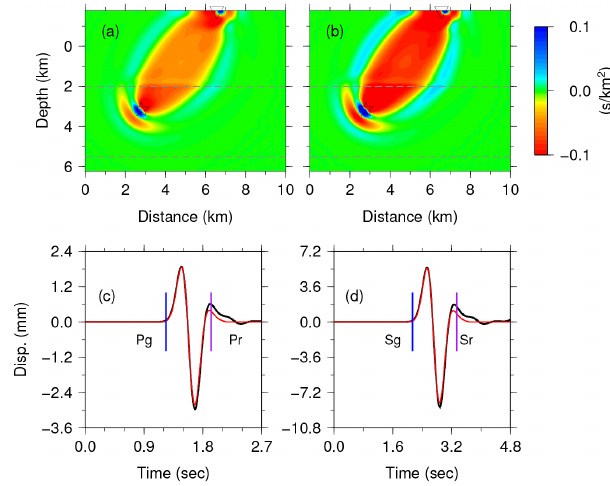
Figure 5. Panels a and b show examples of travel-time sensitivity kernels for the starting model m 1 of (a) the direct P wave ( Pg ) and (b) the direct S wave ( Sg ), which are fully separated from other later phases. The star and the inverse triangle indicate the earthquake at the depth of 3 . 14 km and a recording seismic station on the surface, respectively. The epicentral distance is 3 . 75km. The dashed grey lines denote the velocity discontinuities at the depth of 2.0km and 5.5km. Panels c and d show the corresponding synthetic P wave and S wave seismograms (black curves). The arrival times of the direct waves ( Pg and Sg ) and reflected phases from the discontinuity at 5.5km ( Pr and Sr ) are indicated by the blue and purple lines. The red waveforms are the windowed and tapered seismograms used to compute the travel-time sensitivity kernels of the direct arrivals shown in ( a and b